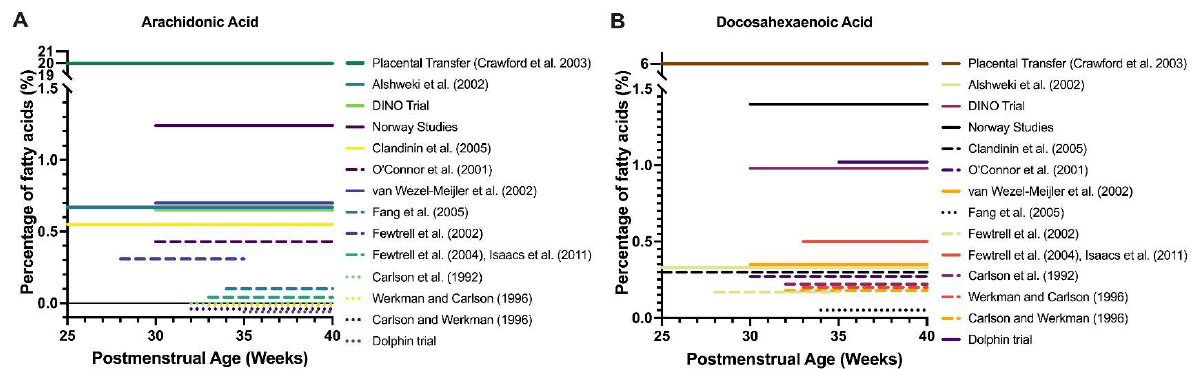
Figure 1. Clinical trials of LCPUFA supplementation in premature infants. Timing and dose of AA ( A ) and DHA ( B ) supplementation as percentage of fatty acids by trial and compared to estimated placental transfer. Note the y-axis breaks, which show that DHA and AA supplementation were at least 4–10 times below levels of placental transfer in the third trimester, regardless of the trial. For AA, all lines below 0% represent 0% of fatty acids as AA but have been separated for display purposes.